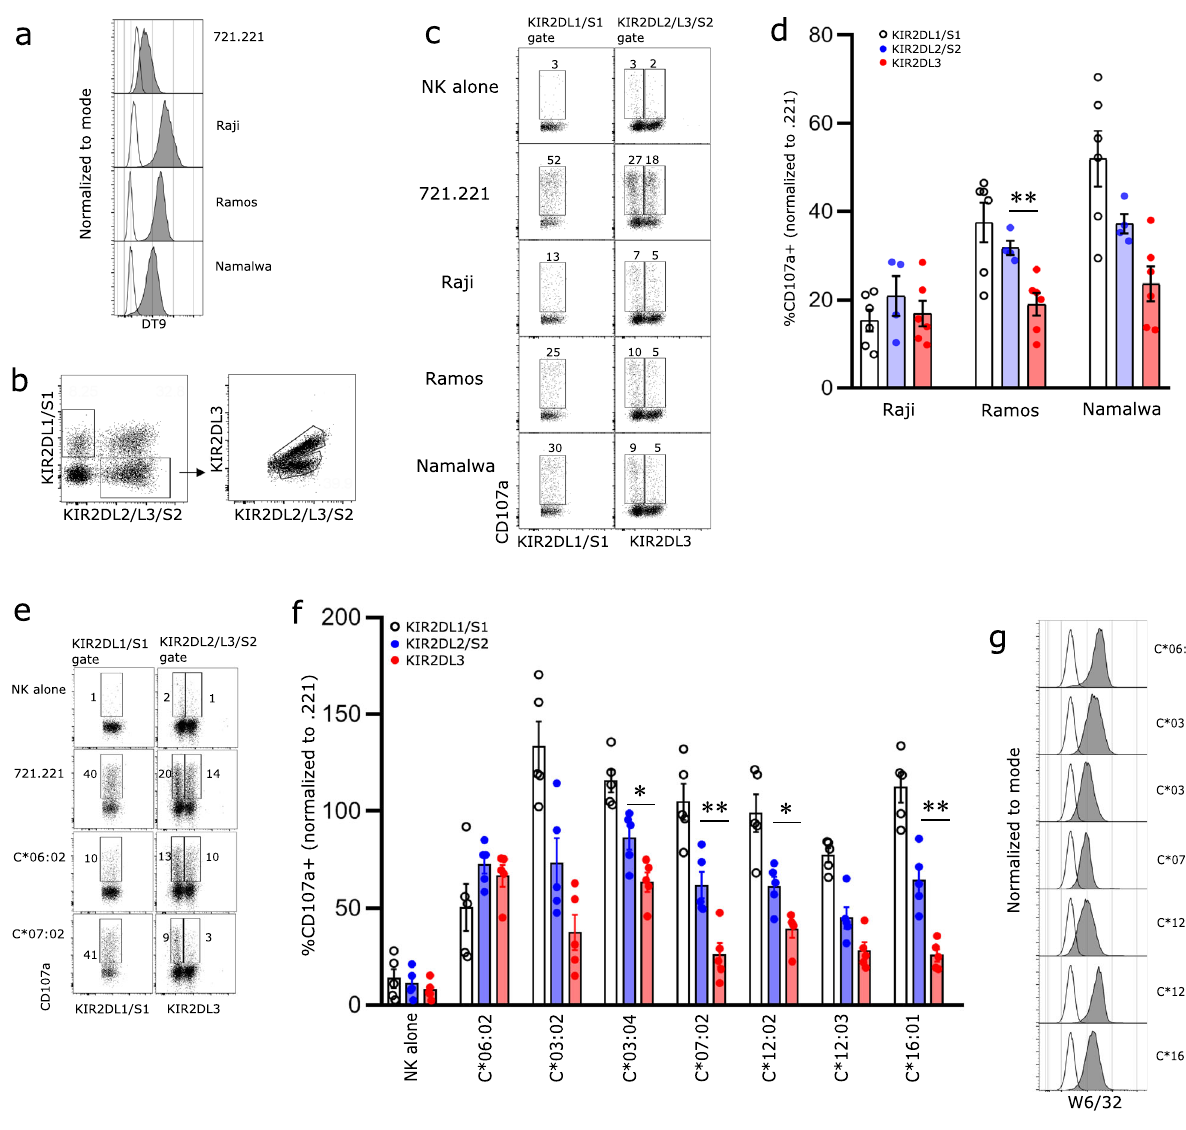
Fig. 5 The functional response of KIR2DL2 and KIR2DL3 NK cells in the presence of HLA ligands. Enriched NK cells from healthy donors were cultured with target cells and the degranulation response of NK cells expressing KIR2D assessed by fl ow cytometry. a The expression of HLA-C on both 721.221 and Raji, Ramos and Namalwa lymphoma cell lines following staining with DT9 antibody (shaded grey area) is shown, with secondary antibody alone shown as un fi lled histogram. b Gating strategy for KIR2DL1/S1, KIR2DL2/S2 and KIR2DL3 NK cells. c Representative fl ow cytometry analysis of CD107a expression on NK cell subsets from one donor in the presence of 721.221, Raji, Ramos and Namalwa cells is shown (gated on KIR3DL1 − NK cells). d Pooled data showing CD107a + cells from six donors with six KIR2DL1/S1, and KIR2DL3 populations and four KIR2DL2/S2 populations is shown. Each symbol represents an individual population of cells and bars depict mean ± SEM values. CD107a response is normalised to 721.221 response from the same experiment. e Representative CD107a expression on NK cell subsets from one donor in the presence of either 721.221 cells or 721.221 cells transfected HLA-C*06:02 or -C*07:02. f The degranulation response of KIR2D + NK cells (GL183 + gated on a set GL183 MFI) to untransfected and HLA-C transfected 721.221 cells. Data are pooled from fi ve donors. Each symbol represents data from an individual donor and bars depict mean ± SEM values. CD107a response is normalised to 721.221 response. g The expression of different HLA-C on target cells stained with W6/32 antibody (shaded grey area) is shown with 721.221 stain shown as black line. Statistical signi fi cance between KIR3DL2 + and KIR2DL3 + subsets (excluding KIR2DL1 + ) was tested using Mann – Whitney test for all conditions; no symbol = p > 0.05; * p < 0.05; ** p < 0.01. Each experiment has been performed twice with data from both experiments pooled for the fi